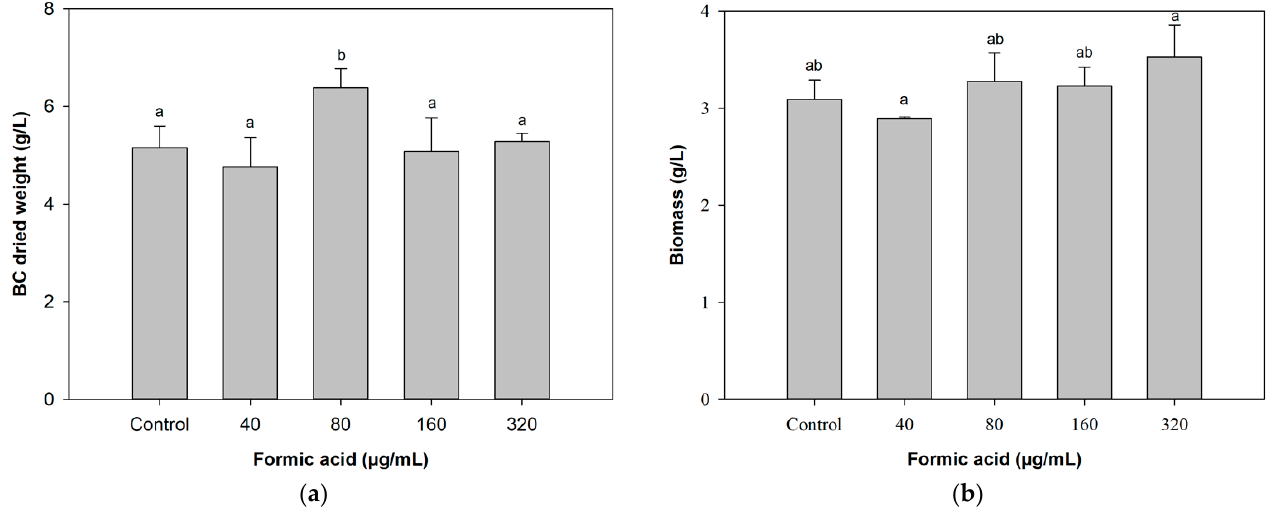
Figure 1. The effect of different FA concentrations on ( a ) BC yield and ( b ) biomass. Each value is expressed as mean ± standard deviation ( n = 3). Different superscripts are significantly different ( p < 0.05).